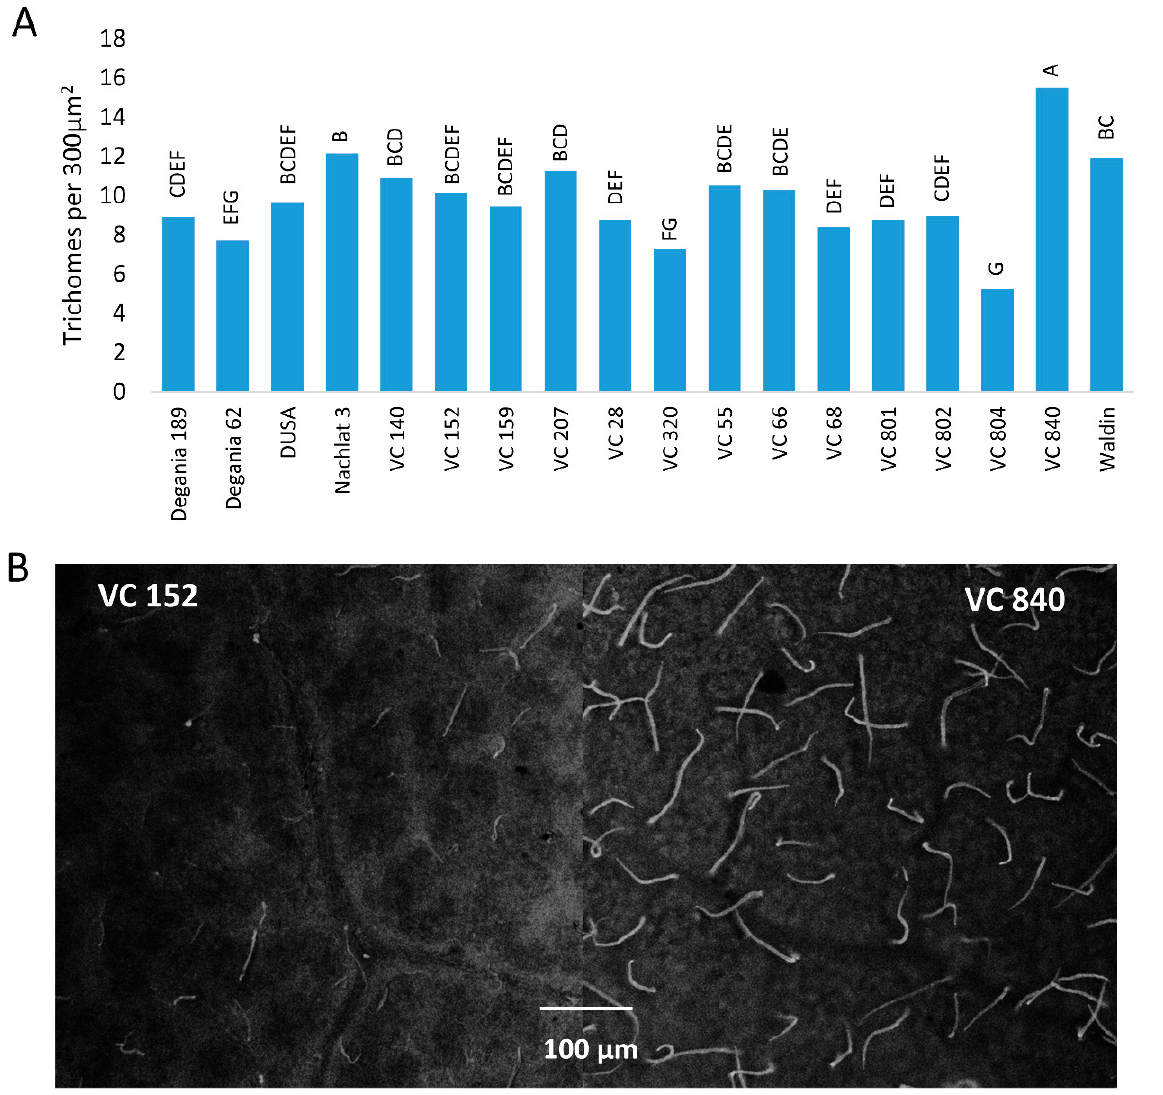
Figure 7. Trichome density on the abaxial side of ‘Hass’ avocado leaves. ( A ): the effect of rootstocks on trichome density after 18 months of salinity exposure. ( B ): live avocado leaves of VC 152 and VC 840 under a stereoscope. Different letters represent significant ( p ≤ 0.05) differences between rootstocks. SD values are presented in Table S1.